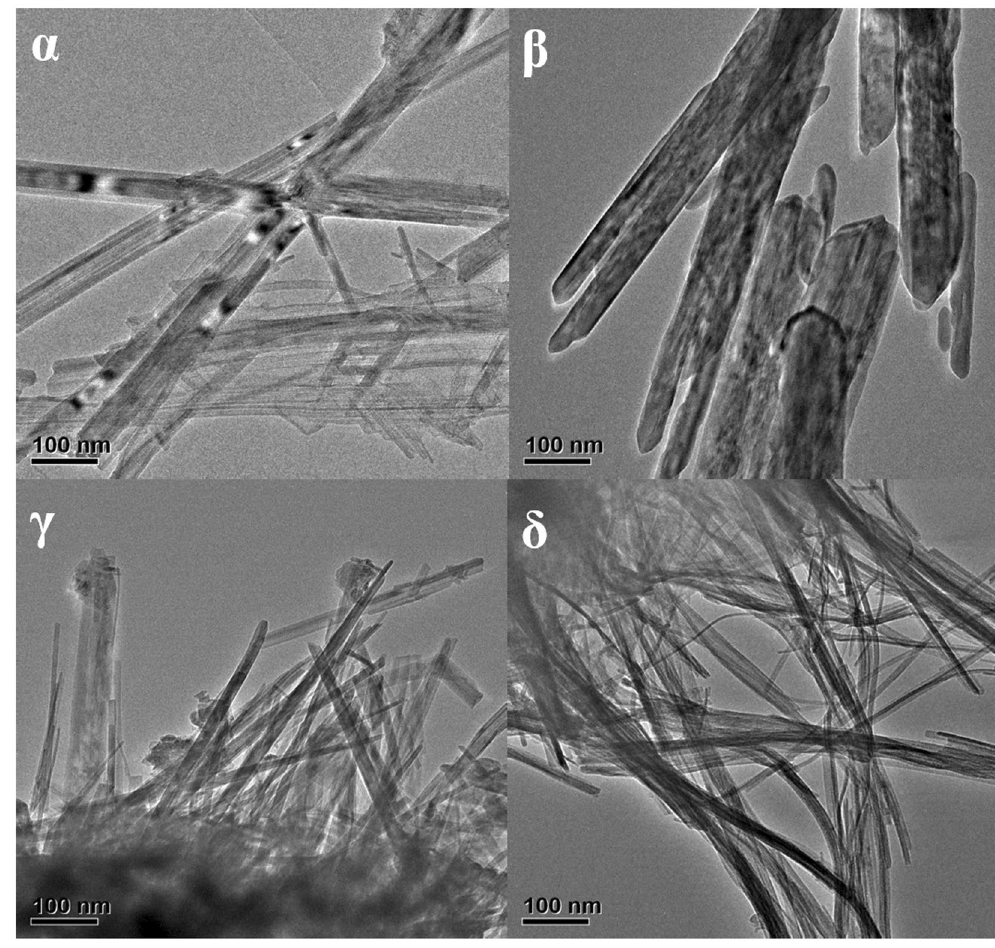
Figure 2. TEM images of α -, β -, γ - and δ -MnO 2